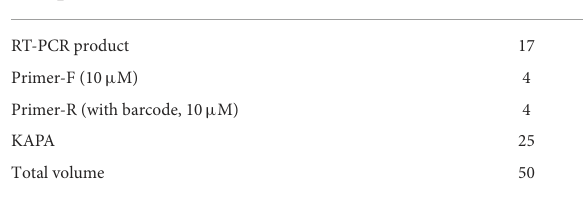
TABLE 6 PCR reaction system and